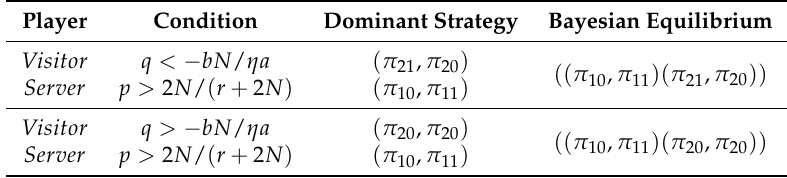
Table 11. List of Bayesian equilibriums for all players when p > 2 N / ( r + 2 N ) . Player Condition Dominant